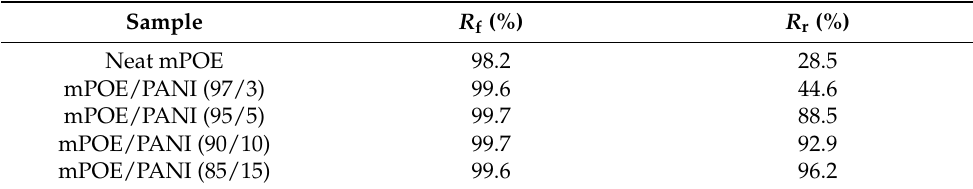
Figure 7. NIR light-induced shape recovery process of mPOE/ PANI blends. Table 3. Shape memory effects of mPOE/PANI blends.